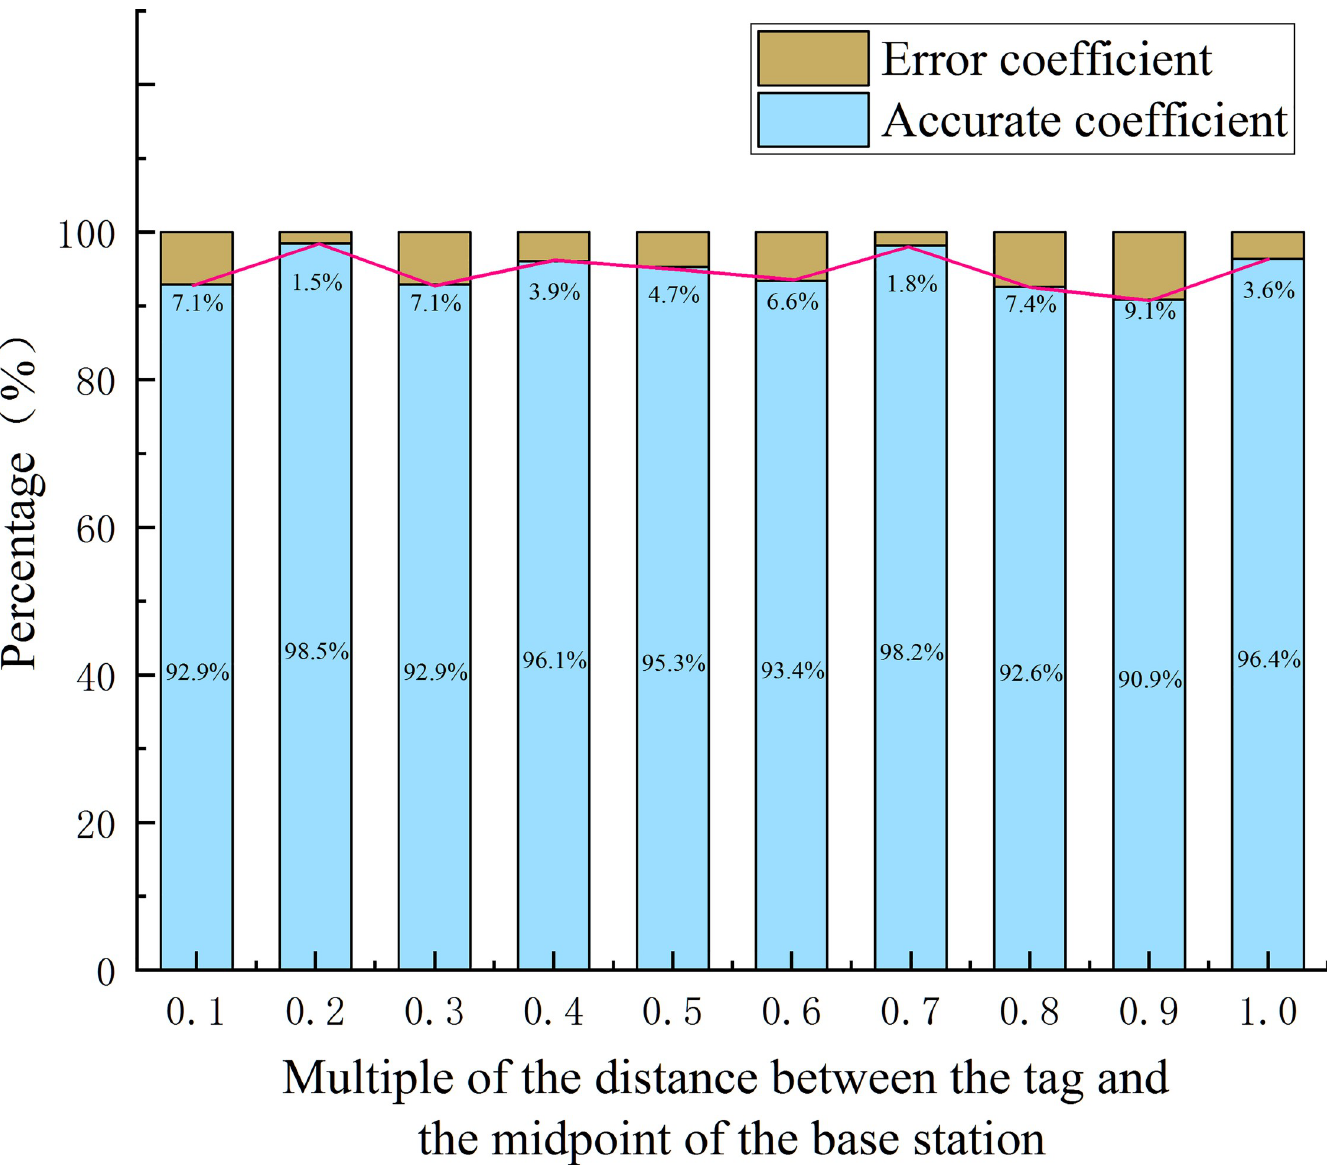
Fig 9. Error in experiment